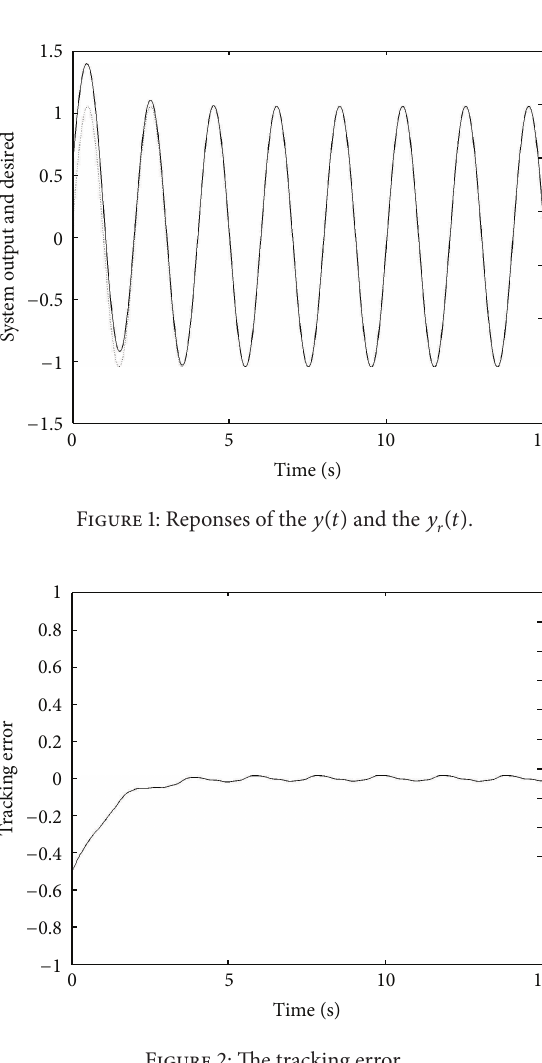
Figure 2: The tracking